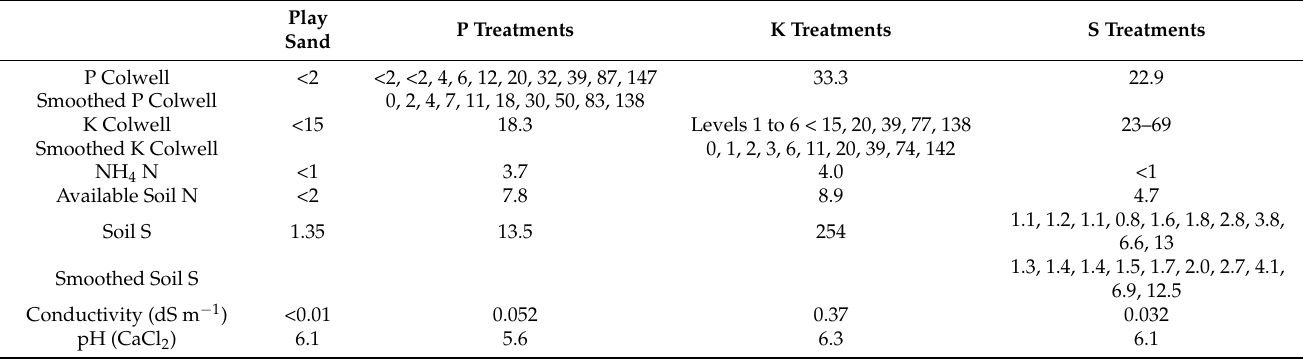
Table 4. Nutrient content analysis and estimated nutrient concentrations based on smoothing models (see statistical analysis section for details) for all treatments. All values are in mg kg − 1